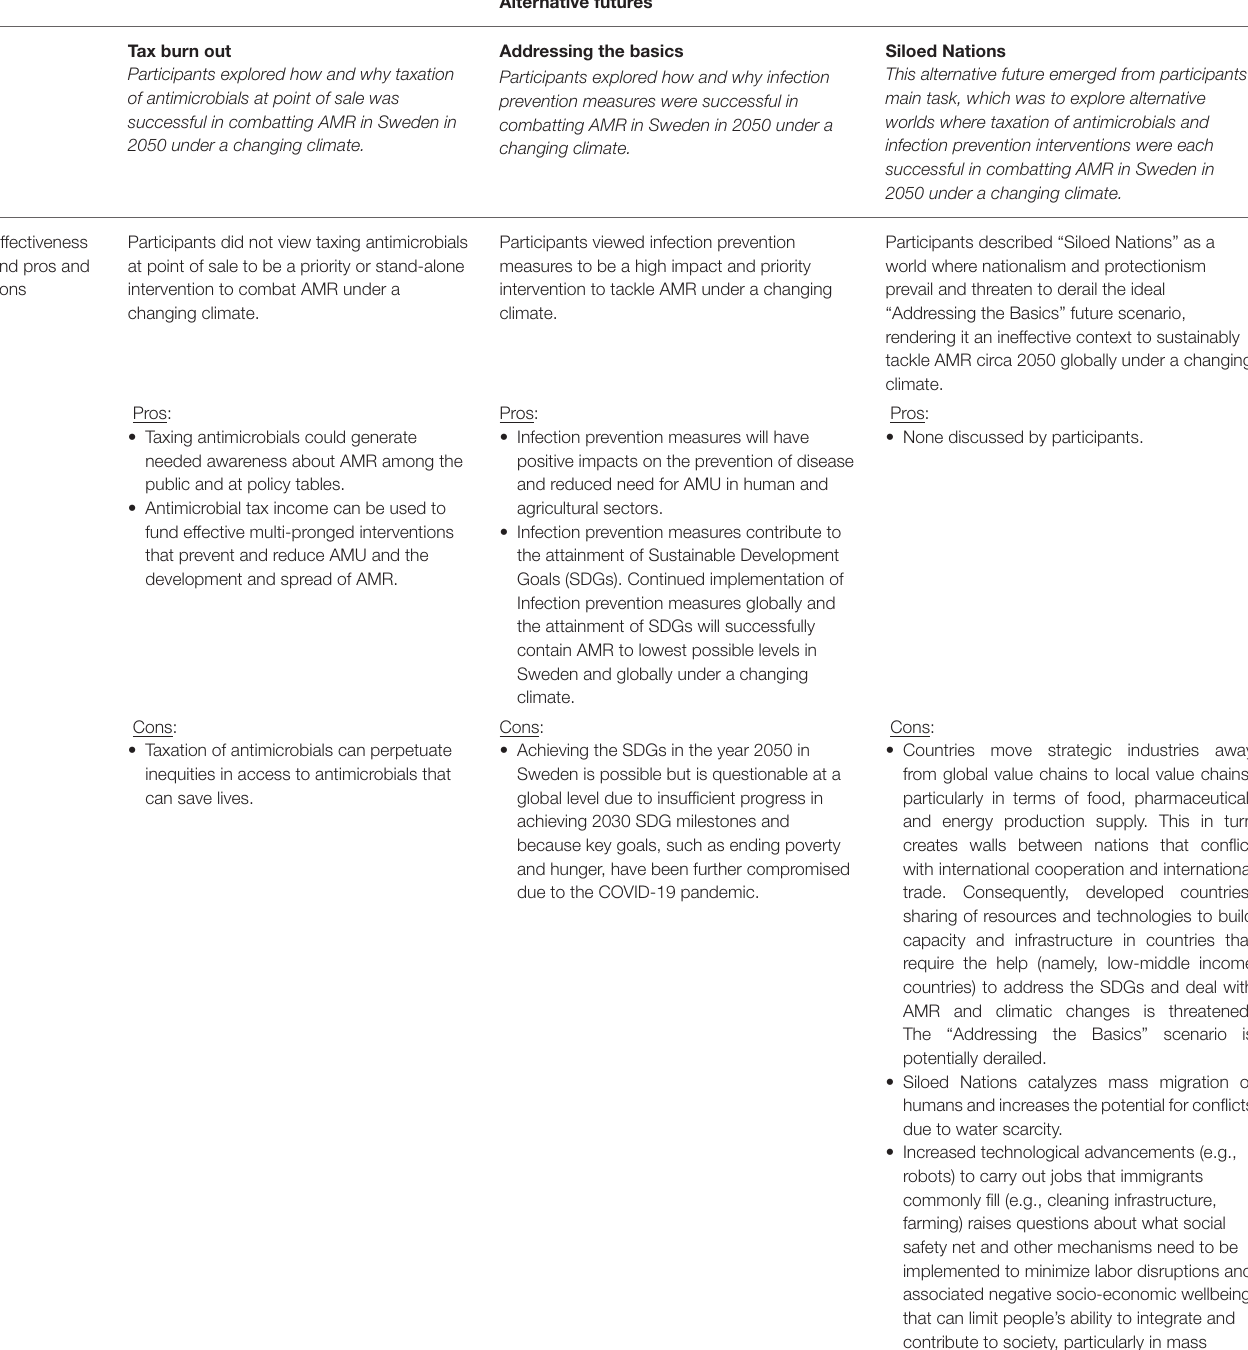
TABLE 1 | Alternative Futures of AMR in Sweden in 2050 under a changing climate: Effectiveness, and pros and cons. Alternative